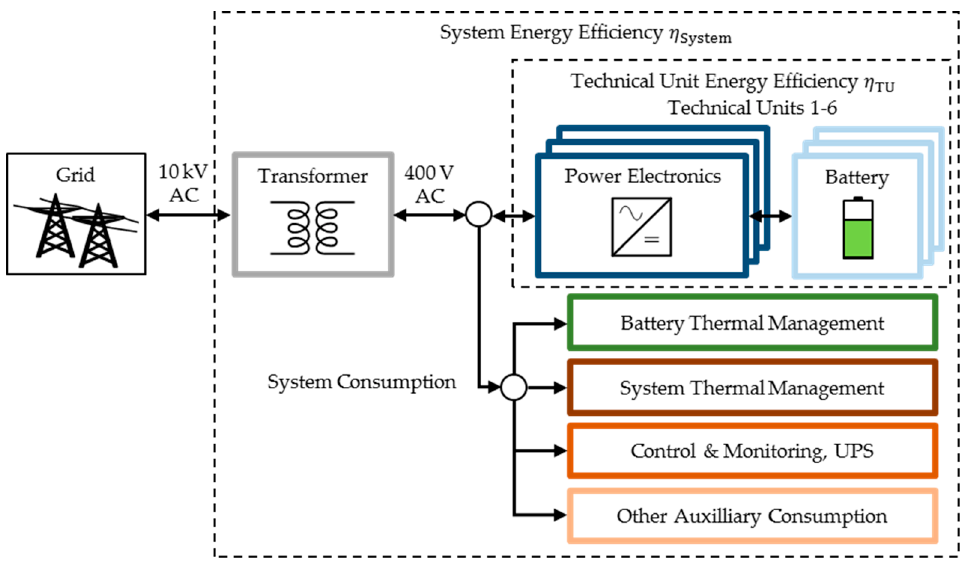
Figure 2. Storage system overview with grid connection and auxiliary components.